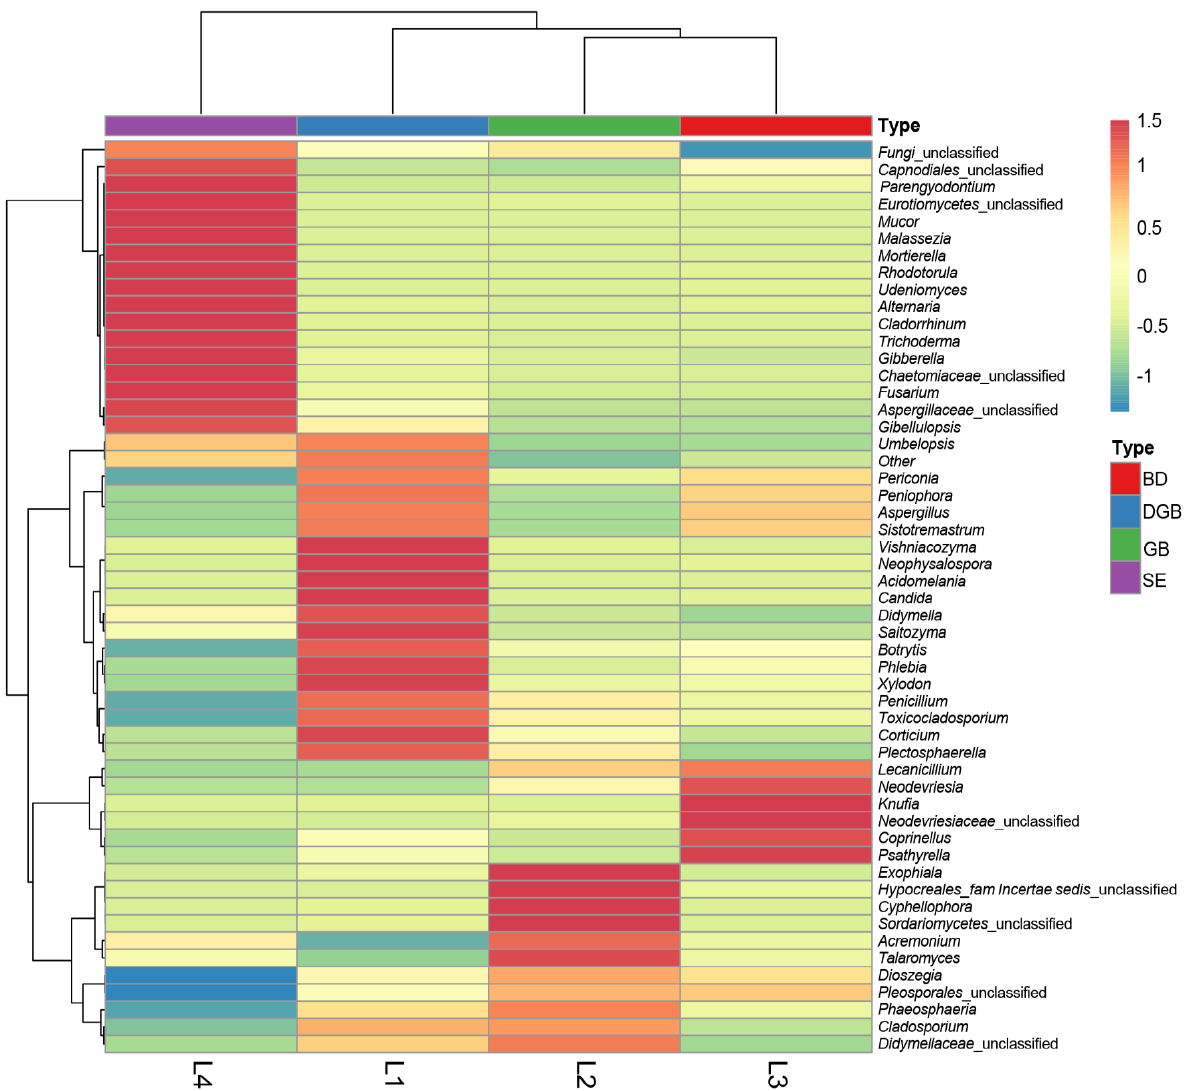
Figure 5. Venn diagram analysis of shared genera between samples.